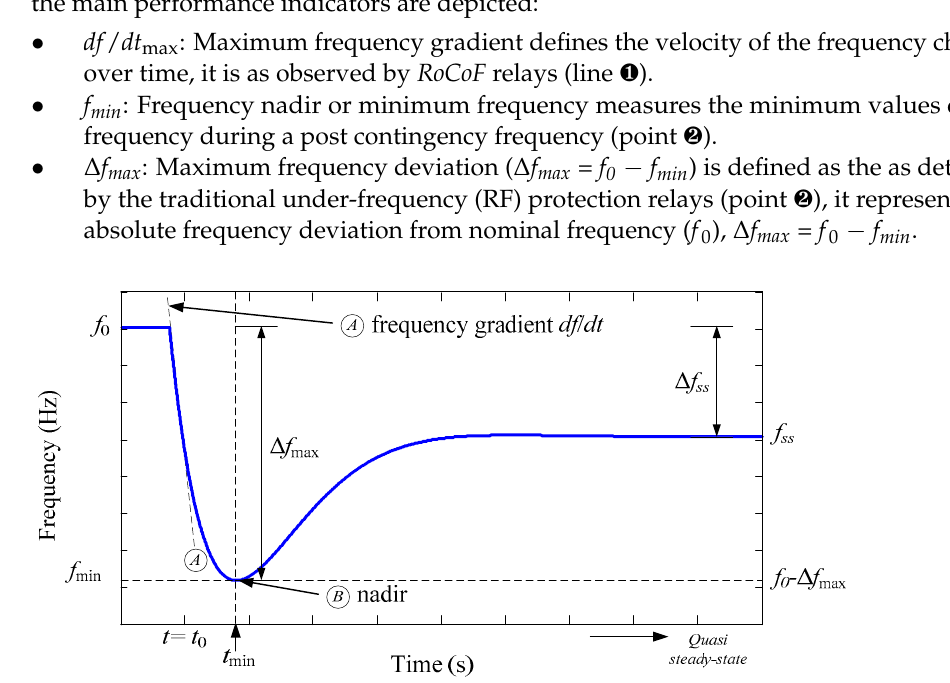
Figure 1. Illustrative example of the system frequency response for an under-frequency event indicating time scales of the controllers. The numerical values are shown as references, and they are taken from the GB frequency control system.